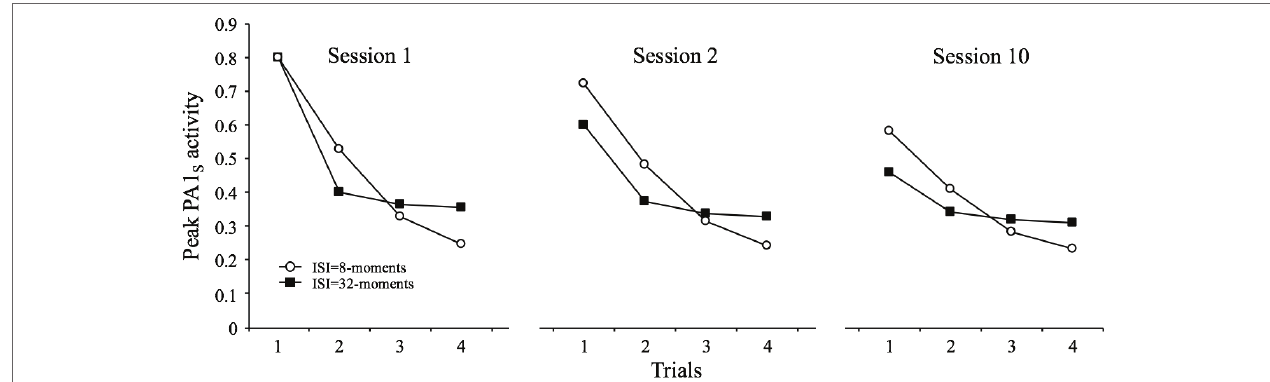
FIGURE 4 | Simulated peak PA1 S activity over 4 presentations of a 1-moment stimulus at inter-stimulus intervals of 8 and 32 moments. The figure contrasts the courses of within-session decrements and spontaneous recovery for the two ISIs during the first, second, and tenth sessions of